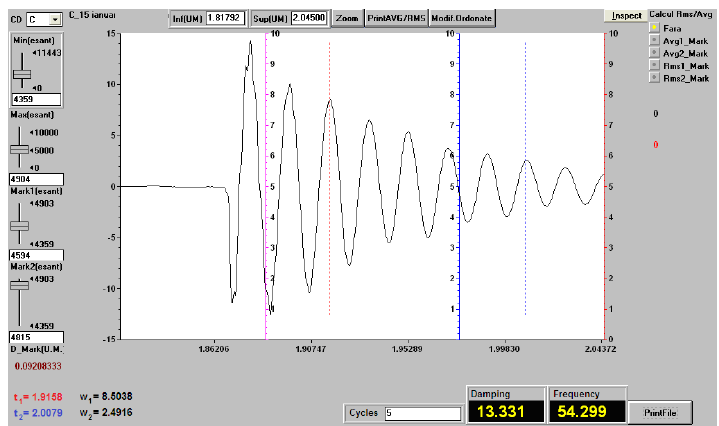
Figure 14. Registration of vibrations (natural frequency and damping factor) at a sample of hybrid resin of type 2, reinforced with first type of flax fabric, for a free length of 200 mm.